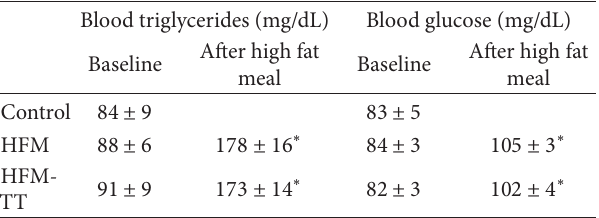
Table 1: Blood triglyceride and blood glucose data. Both blood triglycerides and blood glucose increased above baseline in both high fat meal trials. HFM: high fat meal; HFM-TT: high fat meal plus thermotherapy. ∗ 𝑃 < 0.0125 versus baseline within the same trial. Values are means ±